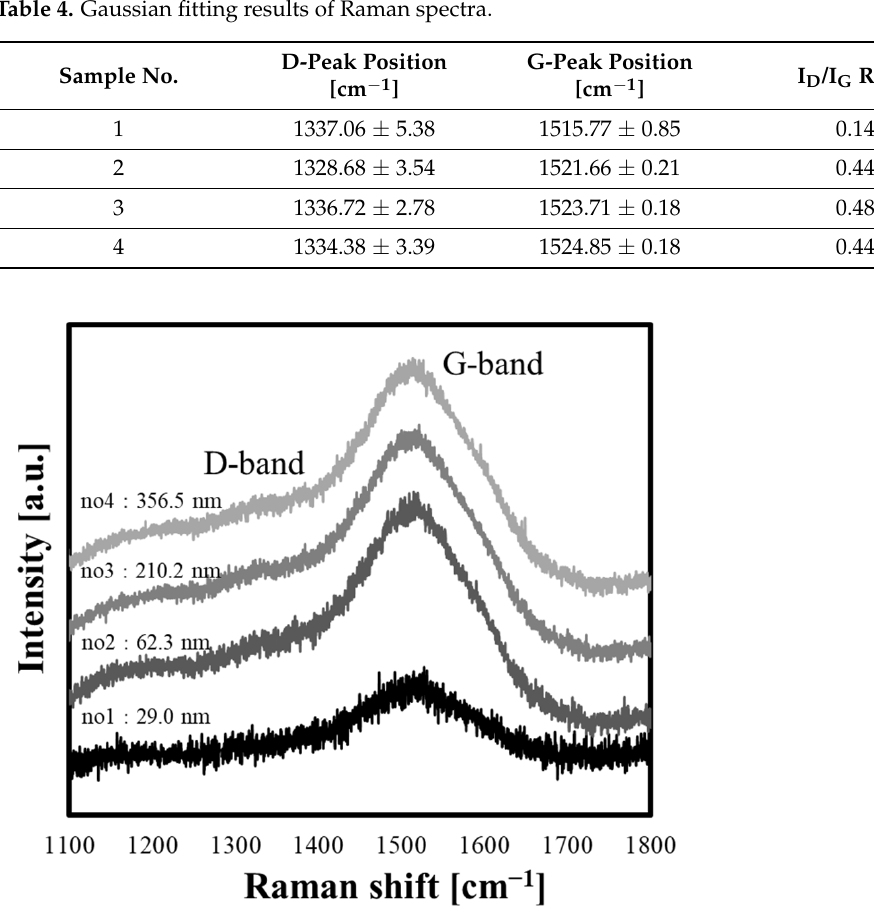
Figure 2. Raman spectra of the polymer-like carbon (PLC) films with different thicknesses. Table 4. Gaussian fitting results of Raman spectra.